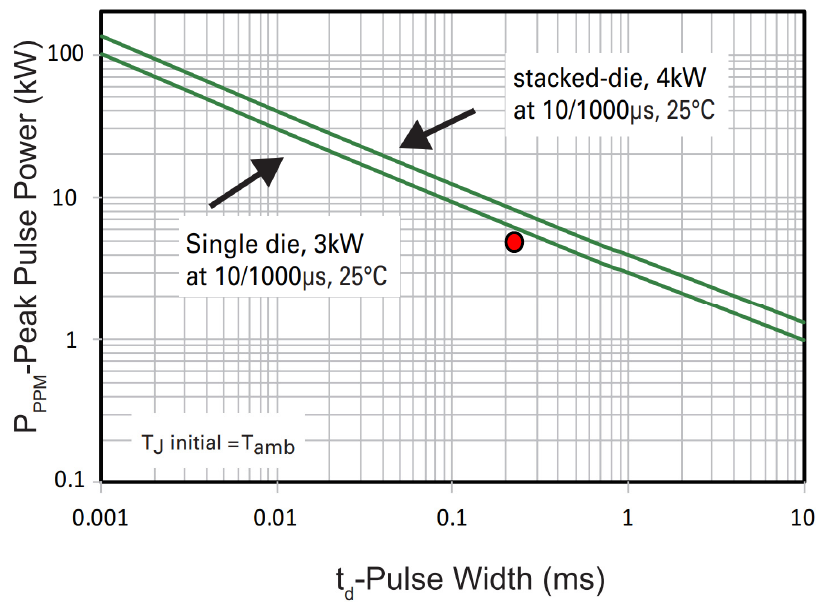
Figure 5. TVS maximum peak pulse power [28].